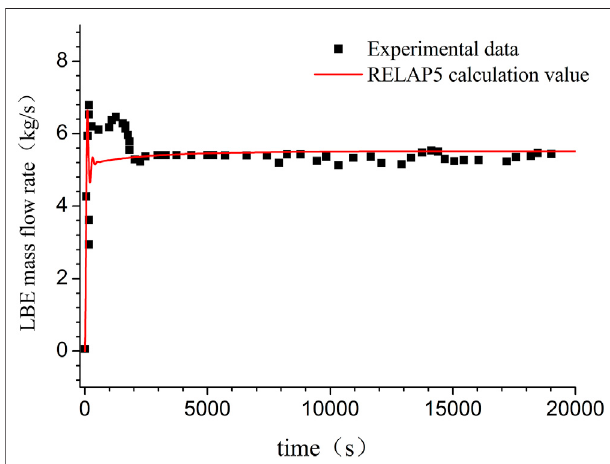
FIGURE 6 | Comparison of the mass fl ow rate of LBE.